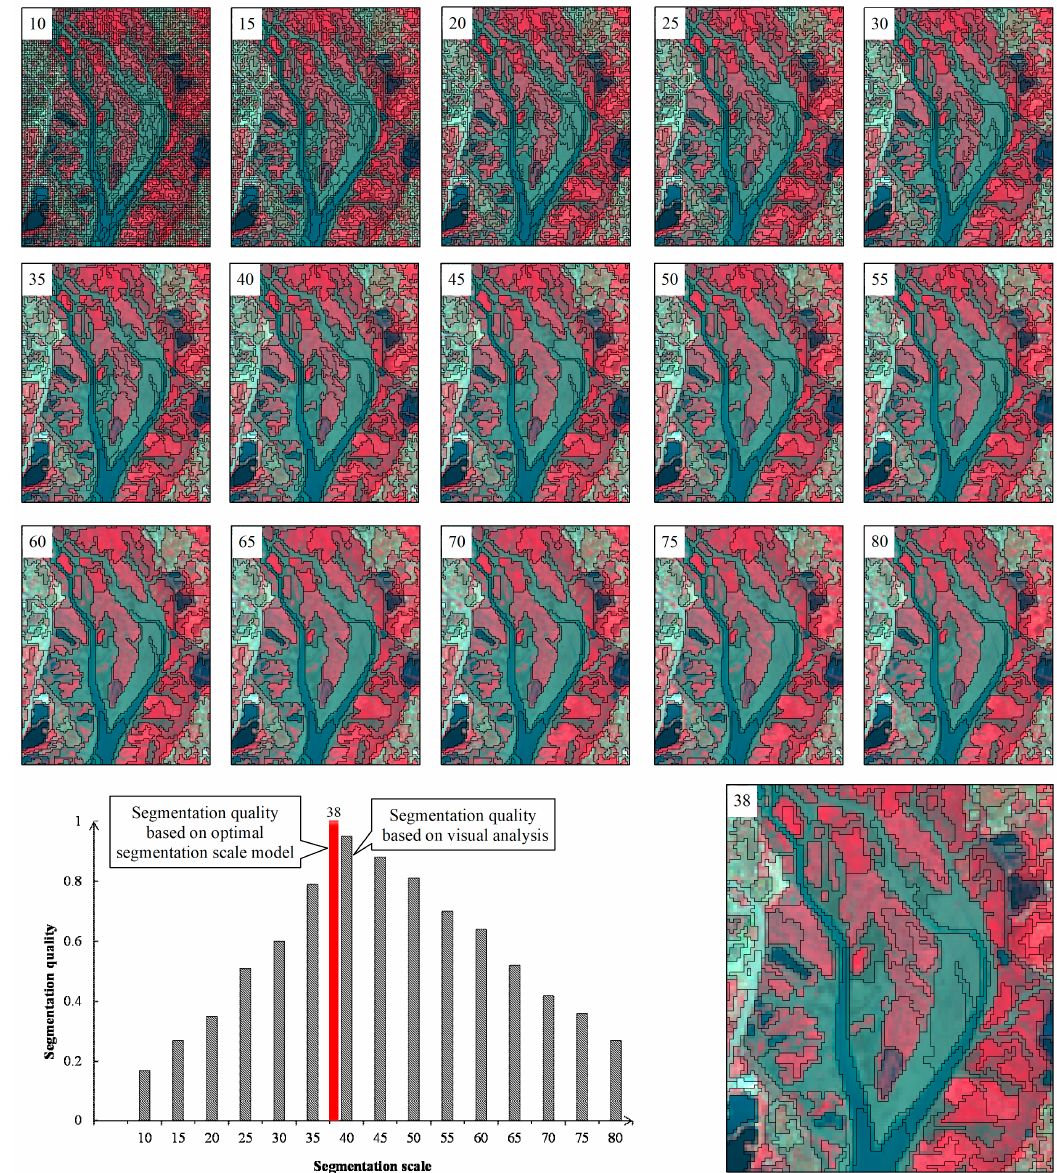
Figure 3. Segmentation effects and segmentation quality evaluation with different scales.